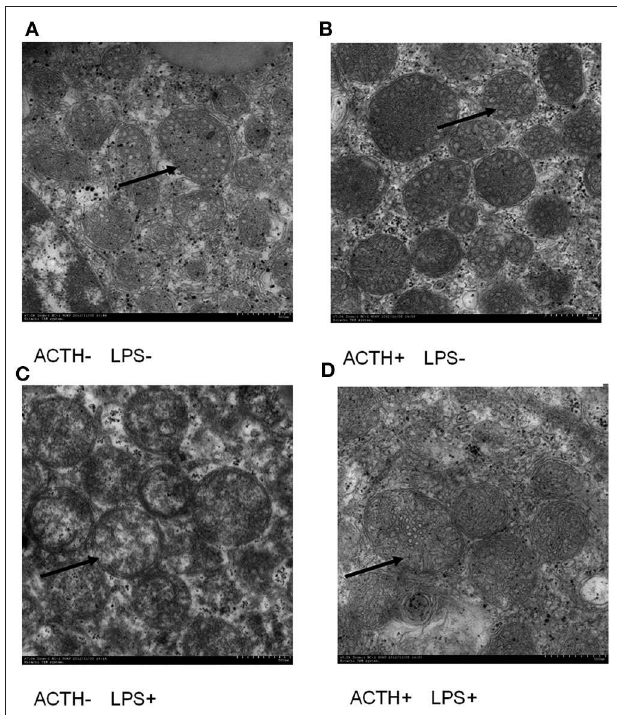
FIGURE 1 | Effect of lipopolysaccharide/ACTH treatment on ultrastructure change of pig adrenocortical cells (arrow, scale bars = 500nm). (A) Vehicle group and (B) ACTH groups show rod-like or round mitochondrias with characteristic tubovesicular cristae (arrow). (C) LPS group shows extremely round mitochondrias with a smooth outer membrane and disappeared cristae (arrow). (D) ACTH + LPS group shows mitochondrial cristae with tubovesicular structure